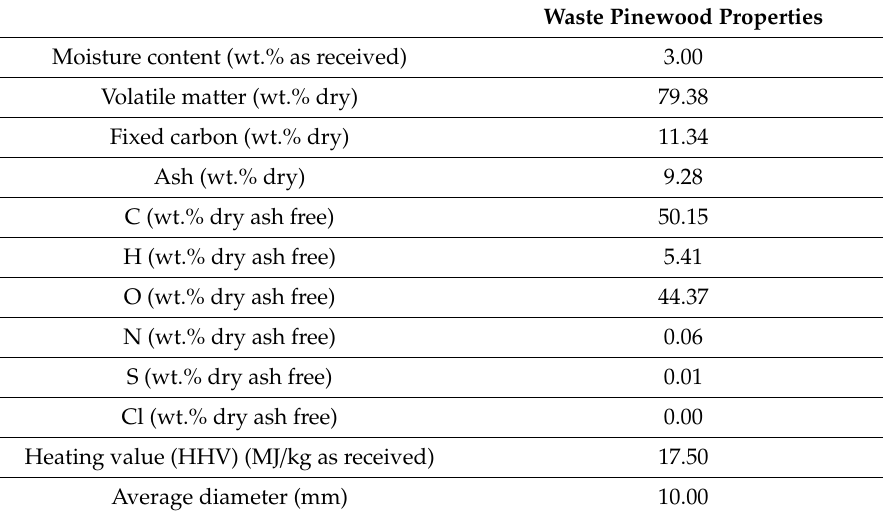
Table 3. Biomass feedstock